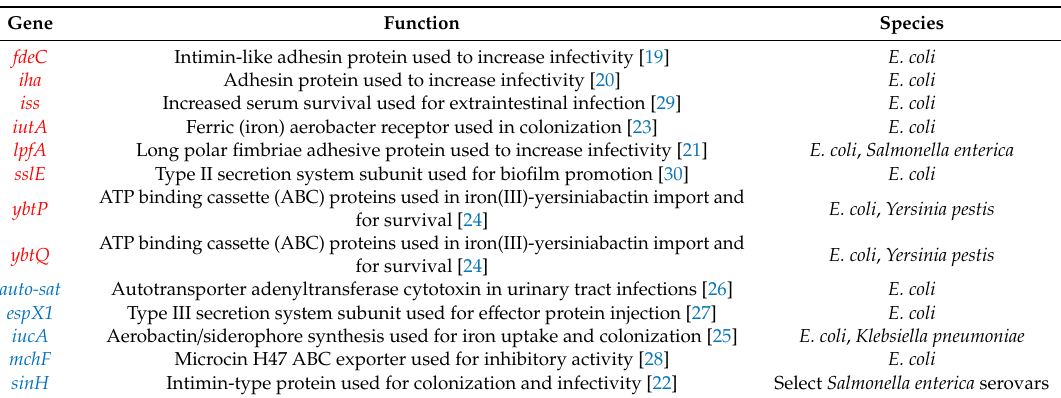
Table 2. A summary of the important virulence genes shared among the five countries with information on gene function, and species of which the gene is found. Highlighted in red are the virulence genes identified in all countries, and in blue are the genes belonging to at least three di ff erent